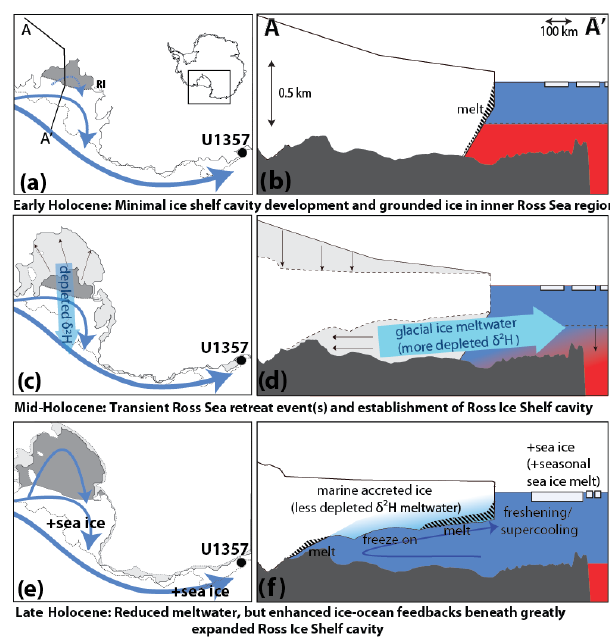
Figure 6. Conceptual model of evolving Holocene glacial and oceanographic conditions in the Ross Sea region. Panels on the left show modelled grounding line positions (McKay et al., 2016) and proposed circulation of surface and sub-ice shelf circulating wa- ters (light blue arrows). Panels on the right show cross sections of the Ross Ice Shelf (RIS) and ice–ocean interactions. Dark blue indi- cates cool surface waters, and red indicates warm subsurface waters. (a) The grounding line in Adélie Land is near its modern location, but near Ross Island (RI) in the Ross Sea and the ice shelf cavity (dark grey shading) it is reduced in size relative to today (McKay et al., 2016). (b) Continental shelf profile A-A’ (a) shows a Ross Sea grounding line in a mid-continental shelf location in close prox- imity to the RIS calving line (McKay et al., 2016), with subsurface warming on the continental shelf triggering WAIS deglaciation (Hil- lenbrand et al., 2017). (c) Most grounding line retreat south of RI occurred between 9 and 4.5ka (light grey shading with black arrows represents area of retreat over this period), proposed to be the conse- quence of marine ice sheet instability, but the ice shelf calving line remained near its present position (McKay et al., 2016; Spector et al., 2017). (d) Grounding line retreat and ice shelf thinning released meltwater with negative δ 2 H into the surface waters. Increasing ice shelf–oceanic interactions with the development of the ice shelf cav- ity (dark grey) led to enhanced Antarctic Surface Water formation; (f) Minimal grounding line retreat has occurred since 4.5 ka, and the RIS super-cools AASW, leading to enhanced sea-ice formation despite reduced glacial meltwater flux. Seasonal sea-ice meltwater further freshens and cools AASW. Increased production of AASW on the continental shelf leads to isopycnal deepening (dotted line) and limits flow onto the continental shelf, slowing further ground- ing line retreat. However, as the ice shelf is near steady-state mass balance and there is a component of marine accreted ice at the base of the ice shelf (Rignot et al., 2013), the strength of the δ 2 H signal is reduced relative to periods of mass balance